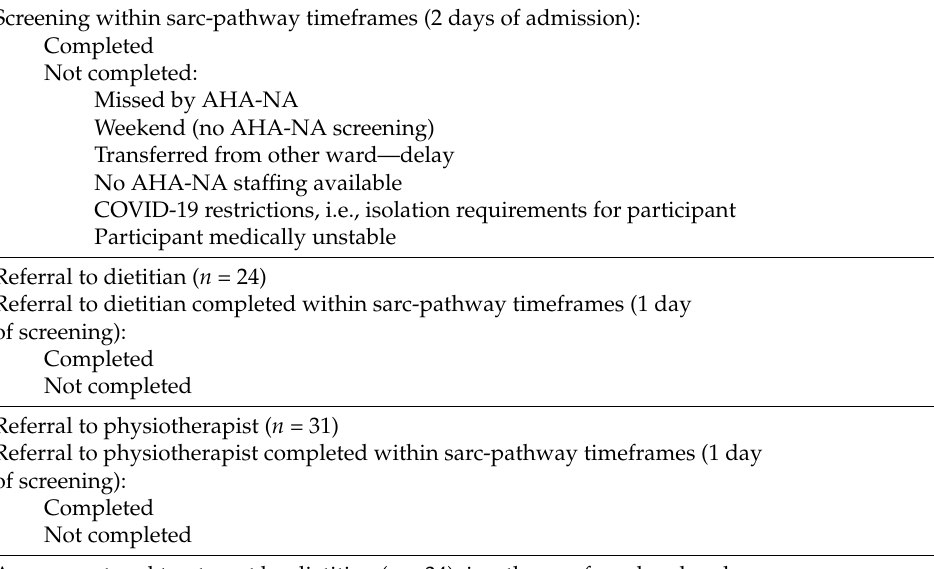
Table 3. Adherence to key ‘time’ components of the sarc-pathway. Component of the Sarc-Pathway n = 159